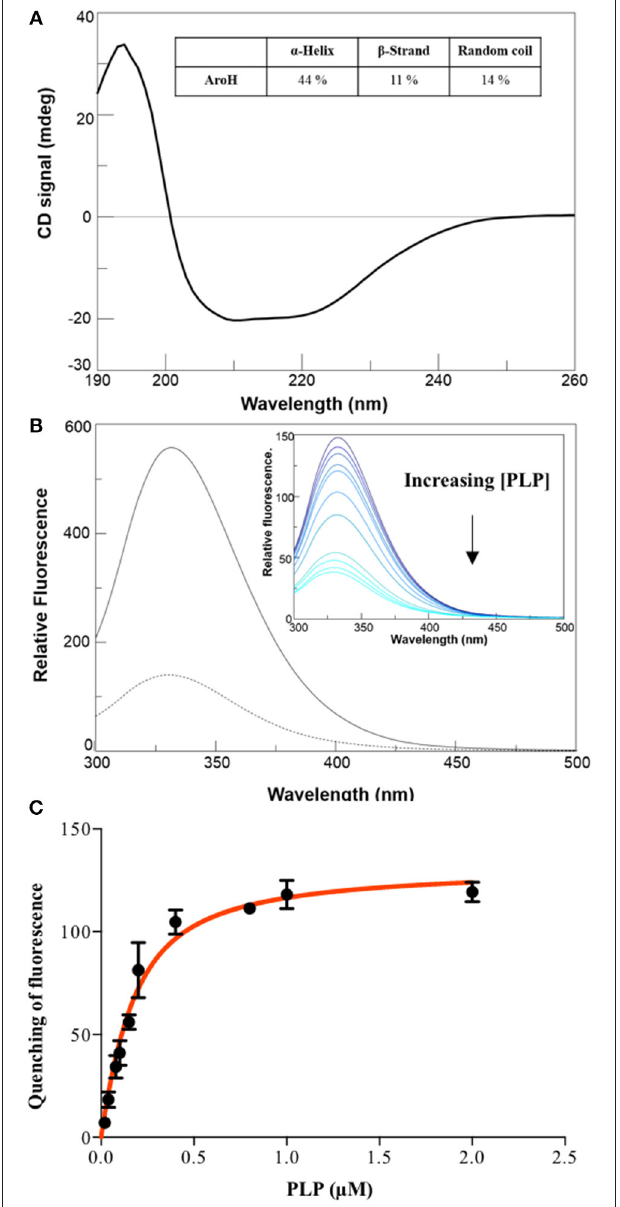
FIGURE 3 | Secondary and tertiary structure of AroH in the apo and holo-form . (A) Far-UV CD spectrum registered at 1 µ M enzyme concentration in KP 0.1M pH 7.4. The inset shows the percentage of secondary structure obtained by spectrum deconvolution. (B) Intrinsic fluorescence emission (exc. at 280nm) of apo- (—) and holo- (- -) AroH at 0.5 µ M concentration in KP 0.1M pH 7.4. The inset shows the quenching of intrinsic emission fluorescence at increasing PLP concentrations. (C ) K D(PLP) calculation. The graph shows the quenching of the AroH intrinsic fluorescence as a function of PLP concentration. The line shows the theoretical fit obtained using Equation 1.